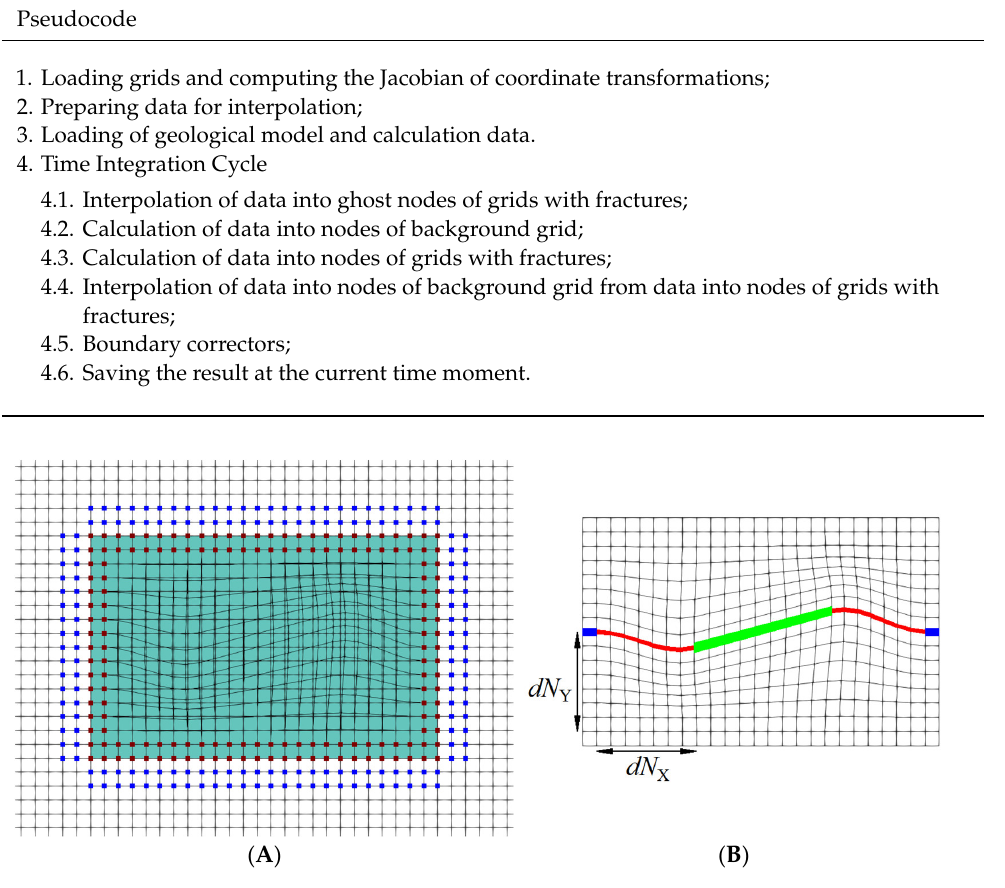
Figure 1. ( A ) Scheme of copying: from the red nodes of the curvilinear mesh to the background mesh and from the blue nodes of the background mesh to the ghost nodes of the curvilinear mesh; ( B ) curvilinear mesh around the fracture.